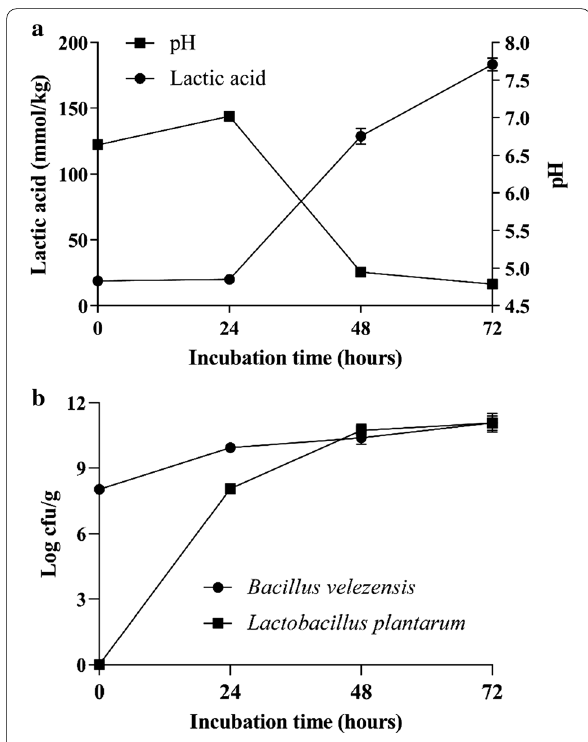
Fig. 1 pH, lactic acid concentration (mmol/kg) ( a ) and the number of microbial ( b ) in uninoculated SBM and FSBM during two-stage